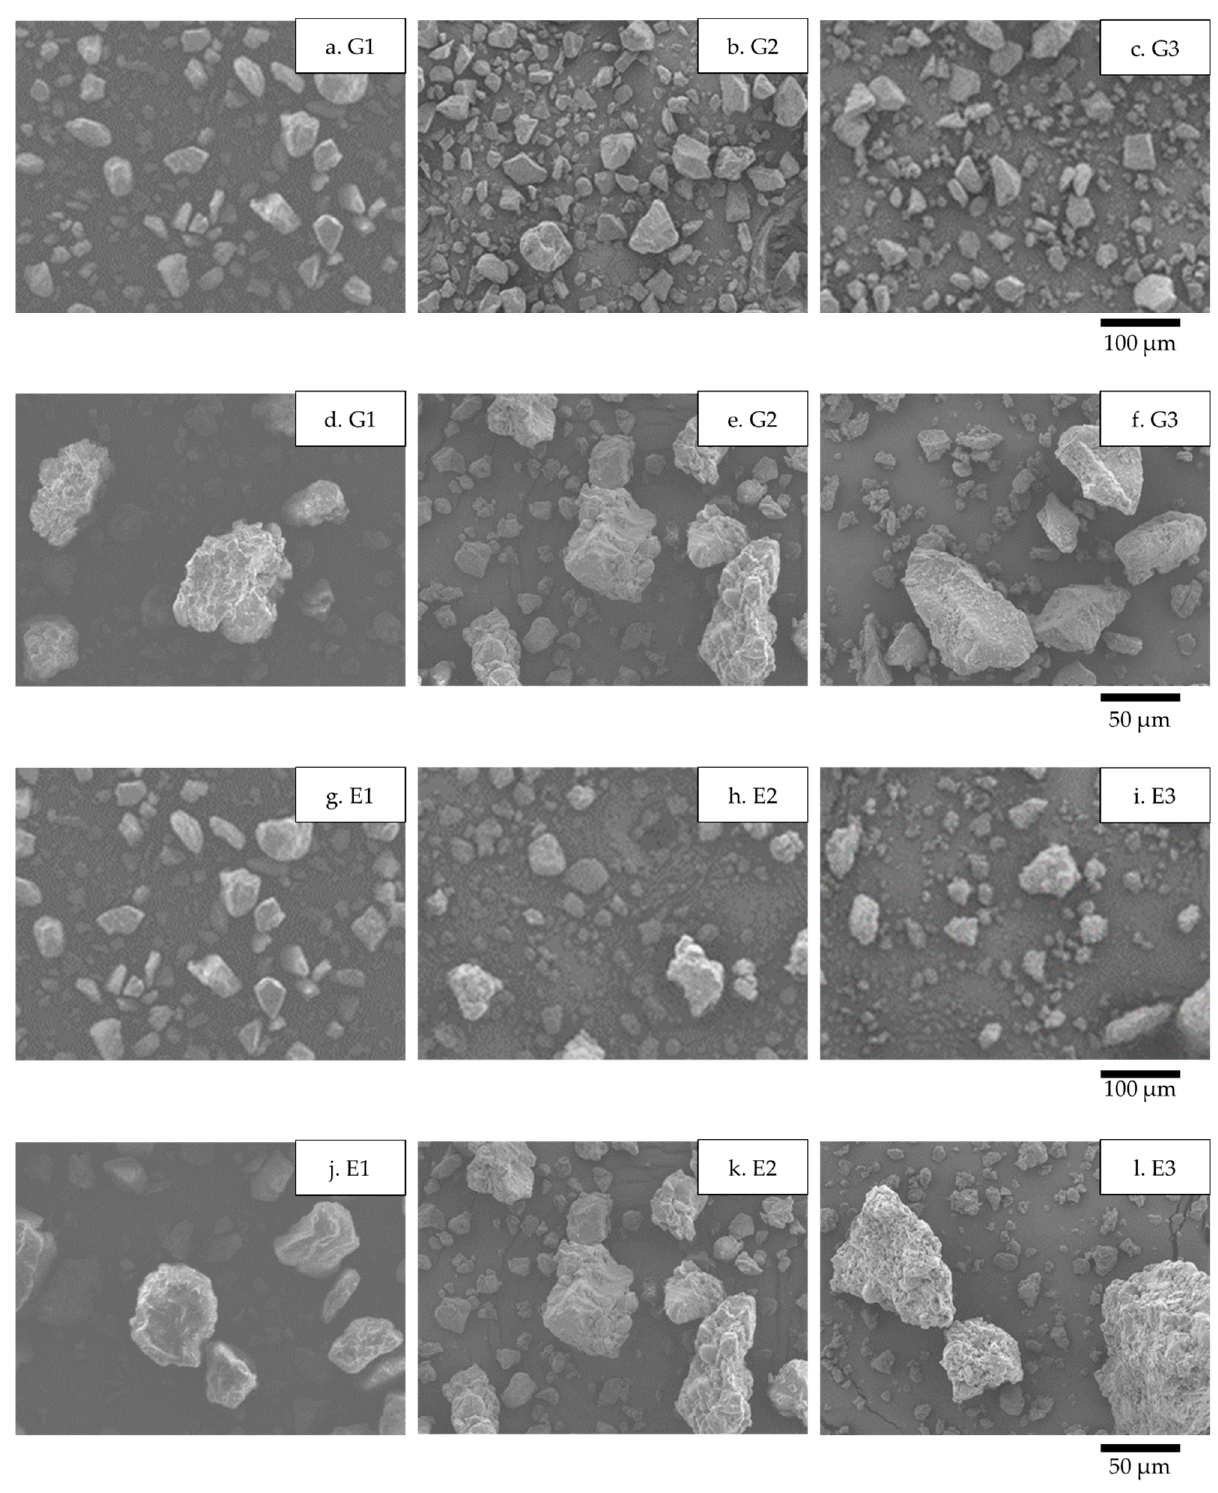
Figure 3. SEM images of the powder particles, ( a – f ) Powders G1, G2, and G3, ( g – l ) Powders E1, E2, and